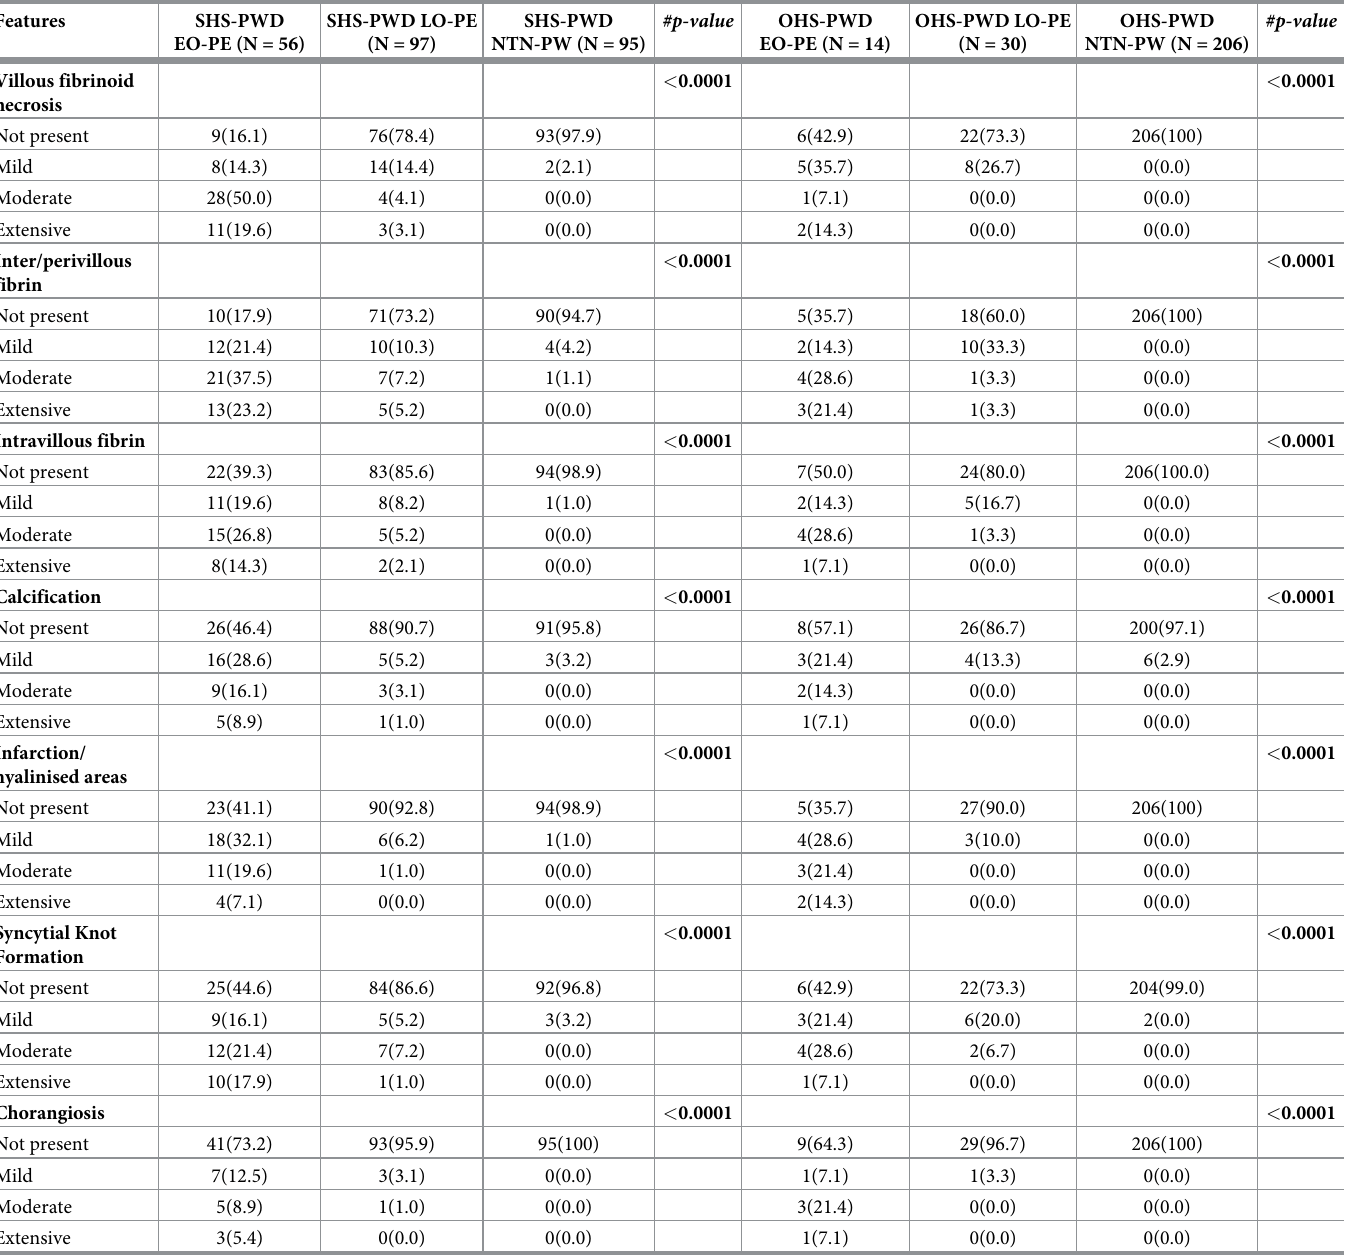
Table 4. Histopathological morphology of the placental villi between SHS and OHS-PWD EO-PE and LO-PE compared to NTN-P.